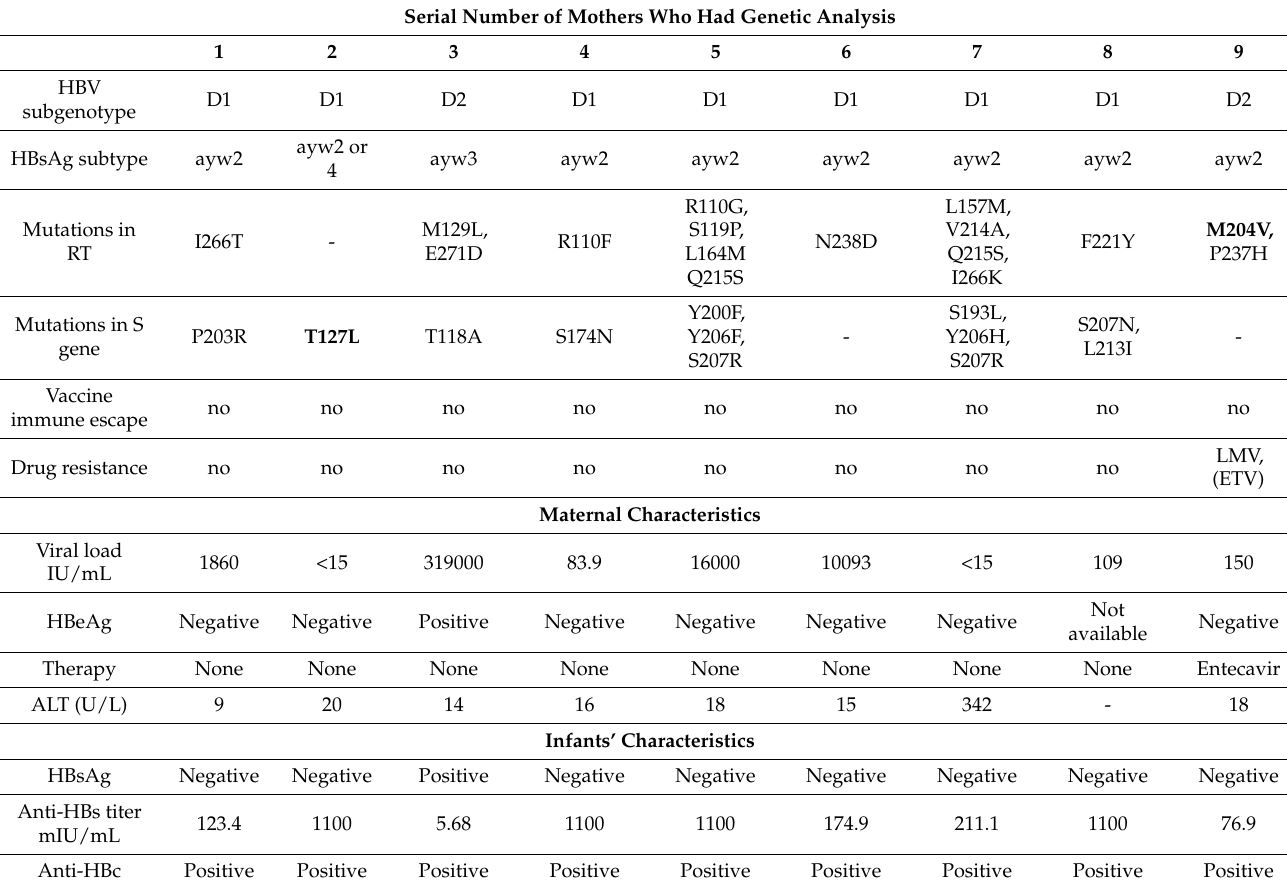
Table 2. HBV subgenotype, HBsAg subtype and S gene mutations in selected 9 cases with positive anti-HBc in the infant at month